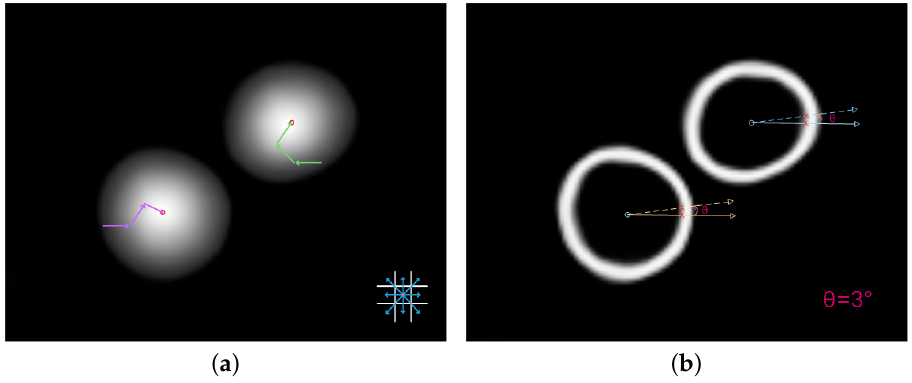
Figure 6. Solution procedure: ( a ) Approximately demonstrate the way to find the center point of fields; ( b ) two points found by our method, which the rest can be deduced